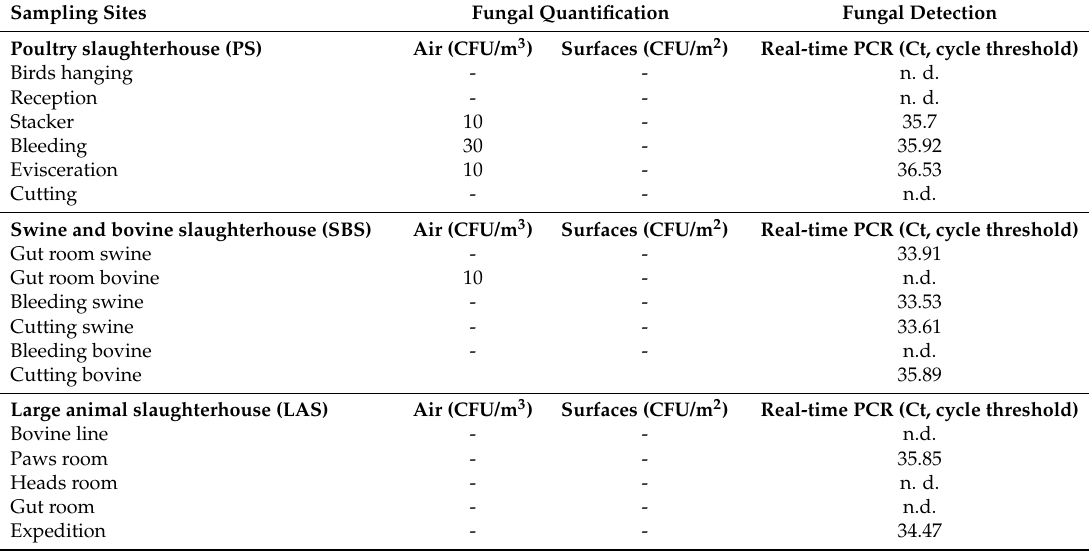
Table 5. Conventional quantification of isolates and molecular detection from A. fumigatus complex in the three